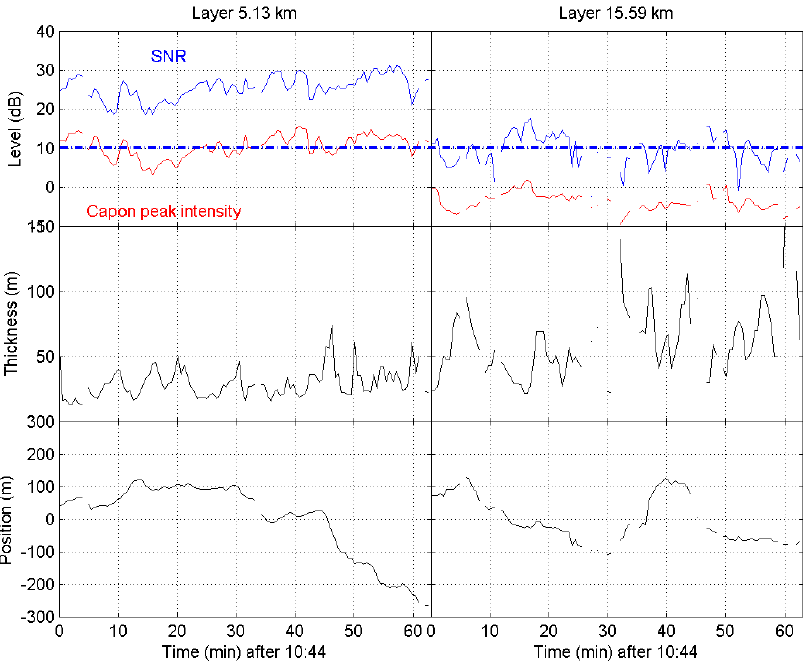
Fig. 7. Time evolution of the position (bottom), thickness (center) and maximum peak intensity and SNR in dB (top) for 2 single layers detected by the Capon method at mean altitudes of 5.13km and 15.59km. The layers are not clearly defined after around 63min for both cases.